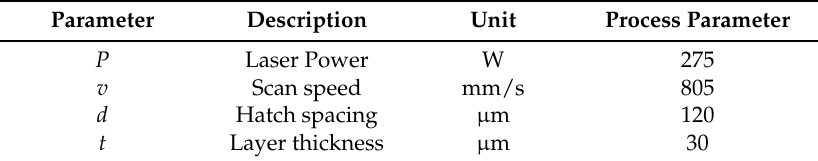
Table 3. Overview of energy-relevant process parameters which were used in the building of all